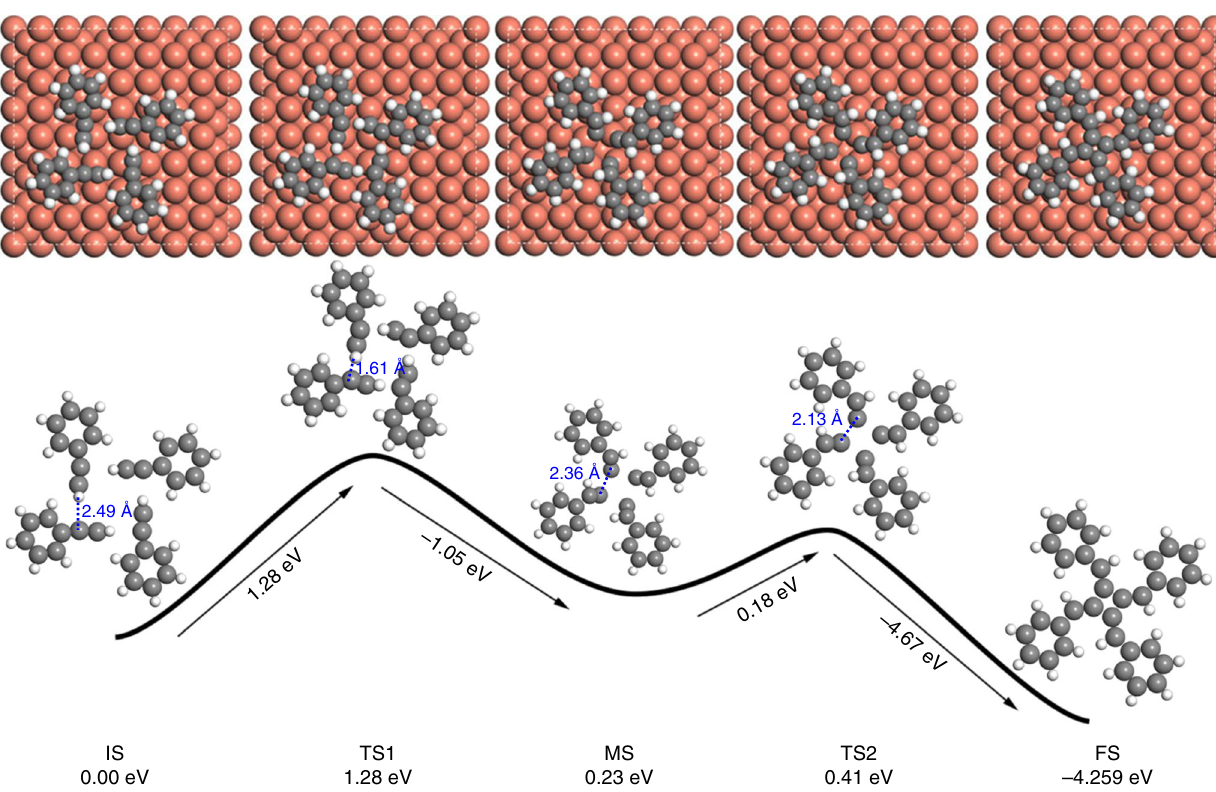
Fig. 5 DFT calculations of the reaction pathway with corresponding energy pro fi les. The cyclotetramerization reaction proceeds via the cooperative intermolecular hydrogen tautomerization and a [1 + 1 + 1 + 1] cycloaddition mechanism